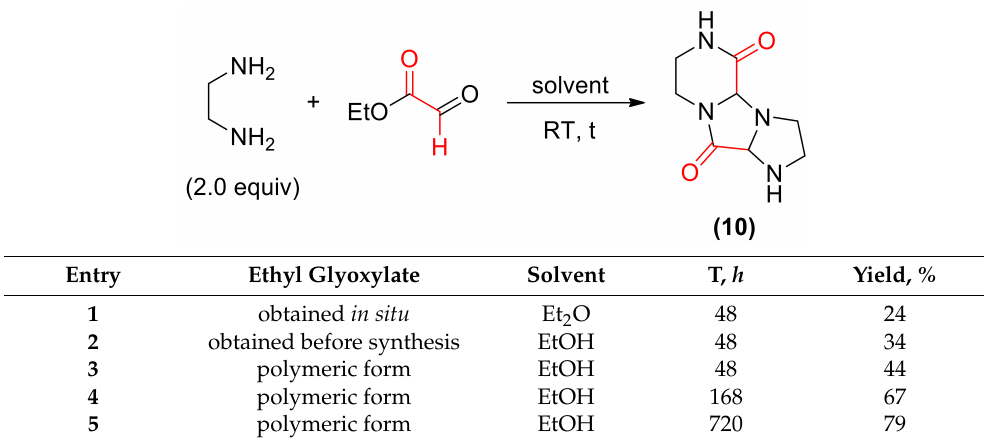
Table 1. Synthesis of tricyclic dilactam 10